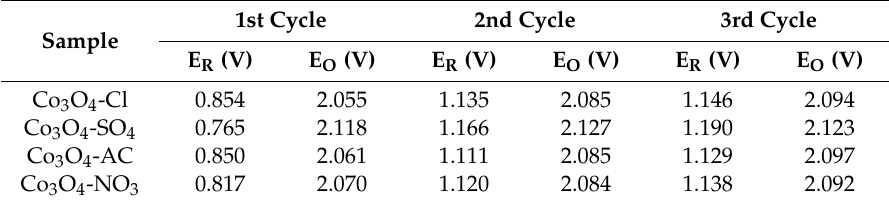
Figure 6. CV curves of ( a ) Co 3 O 4 -Cl, ( b ) Co 3 O 4 -SO 4 , ( c ) Co 3 O 4 -AC, and ( d ) Co 3 O 4 -NO 3 . Table 1. The data originating from the CV curves in Figure